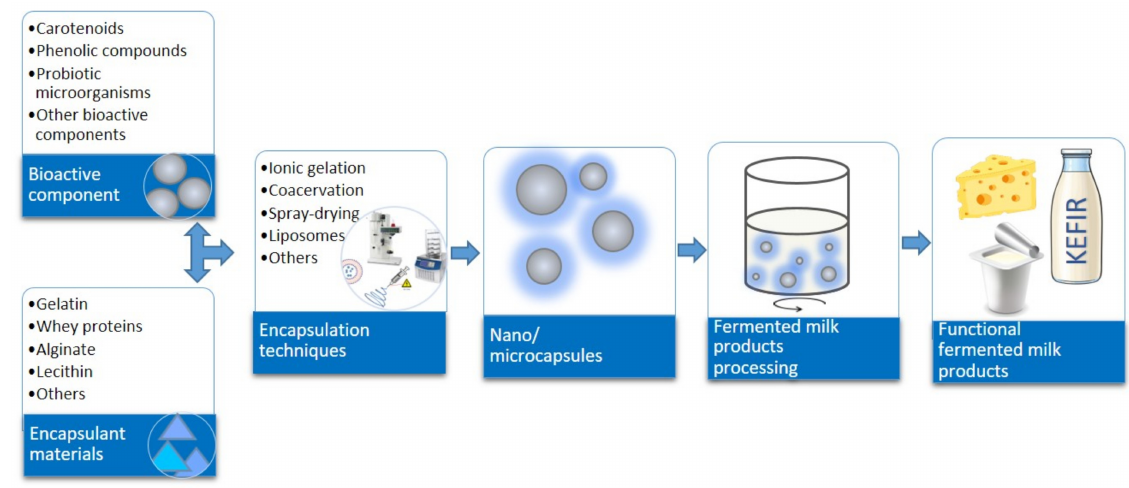
Figure 1. Schematic representation of the delivery of encapsulated bioactive ingredients into fermented milk